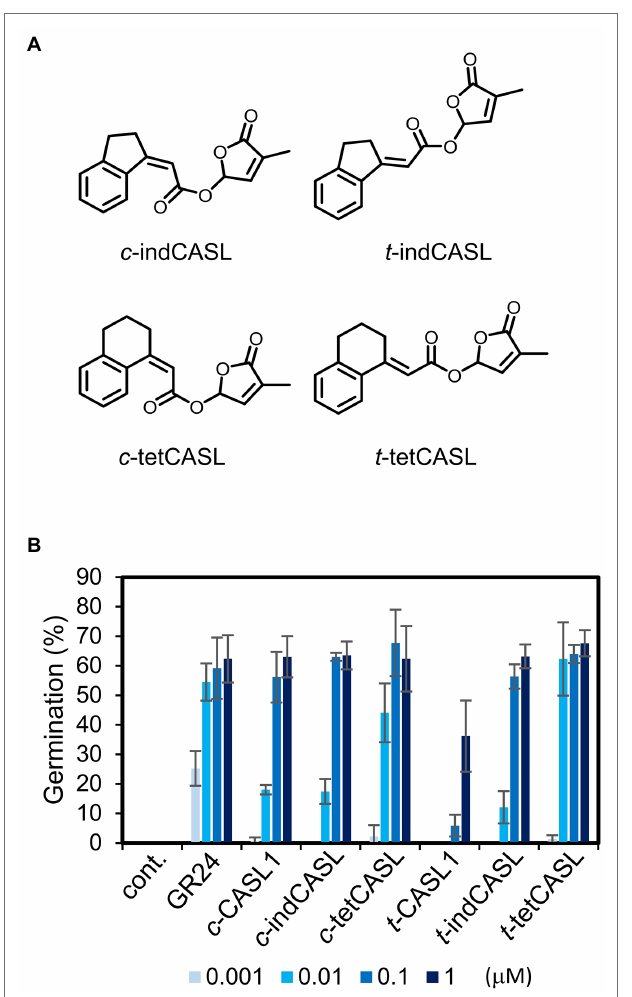
FIGURE 4 | Orobanche minor germination inducing activity of conformationally fixed CA derived SL analogs. (A) Chemical structures of the conformationally fixed CASLs. (B) Germination inducing activity of tested compounds toward O. minor seeds. Data are means ± SD ( n = 3). cont. means control with only acetone at 0.1%.